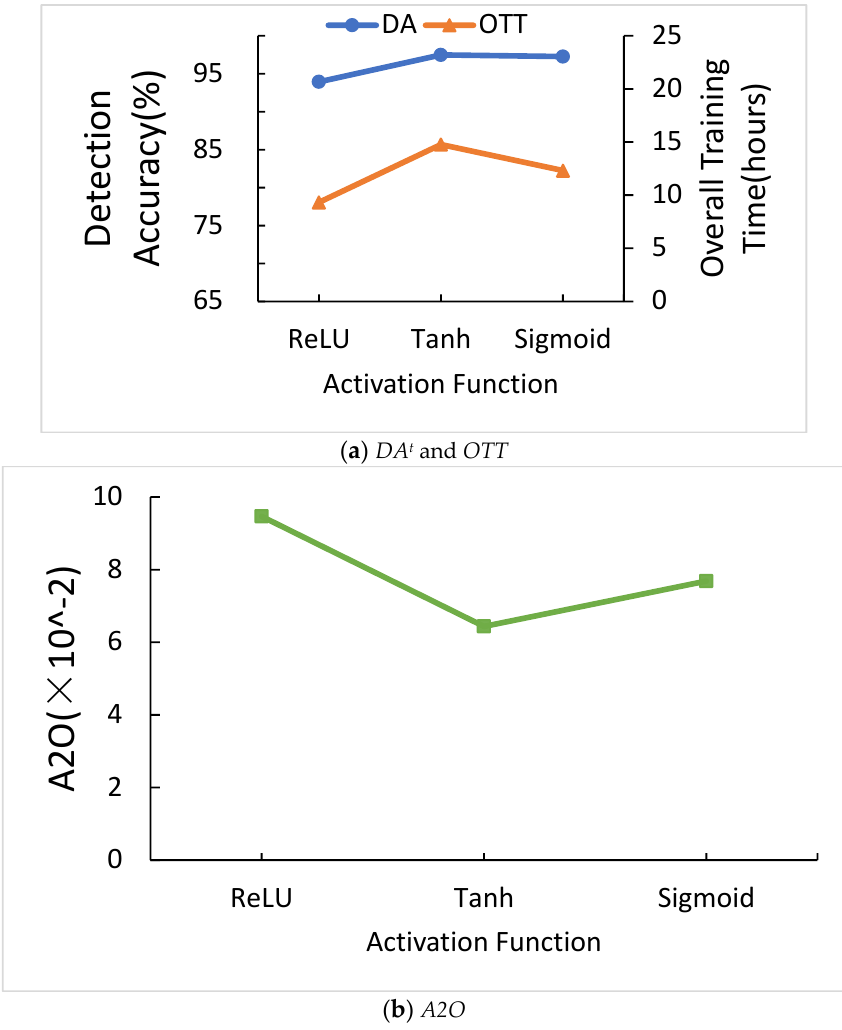
Figure 13. Comparison of different activation functions in CNN. Sensors 2021 , 21 , x FOR PEER REVIEW